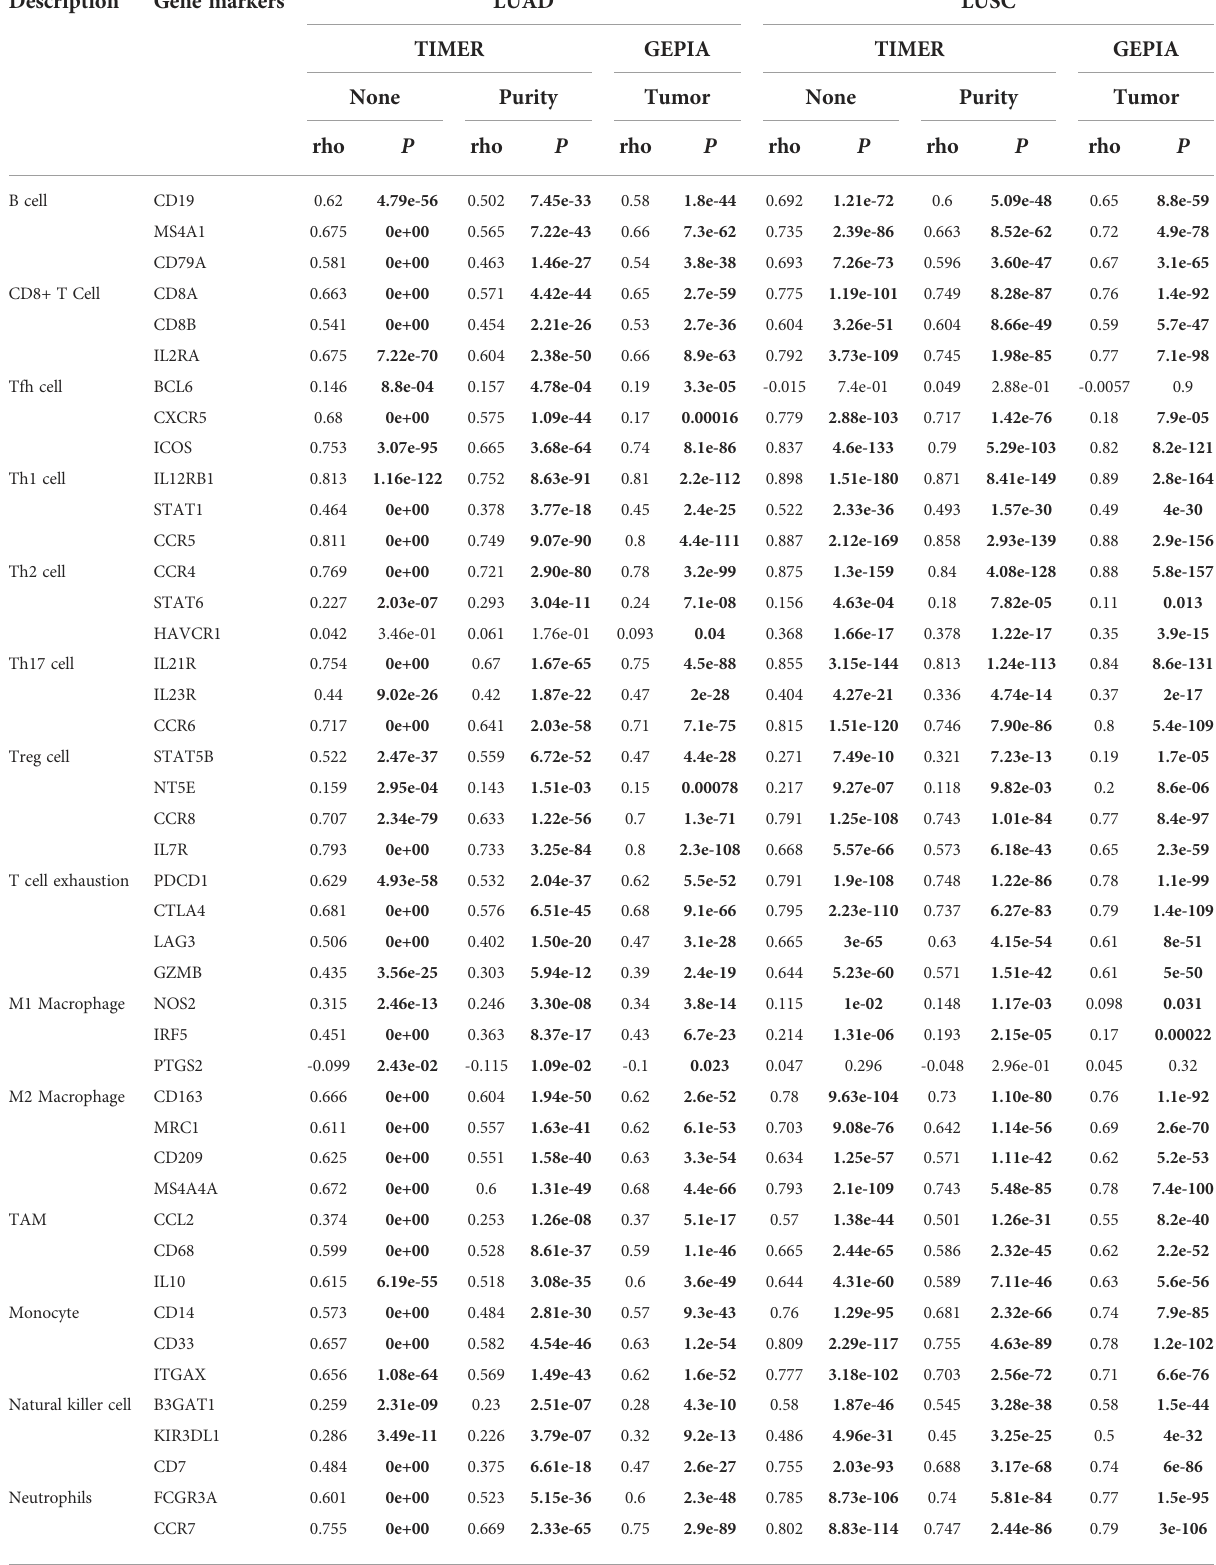
TABLE 1 Correlation analysis between RCSD1 and biomarkers of immune cells in LUAD and LUSC based on the TIMER and GEPIA database.